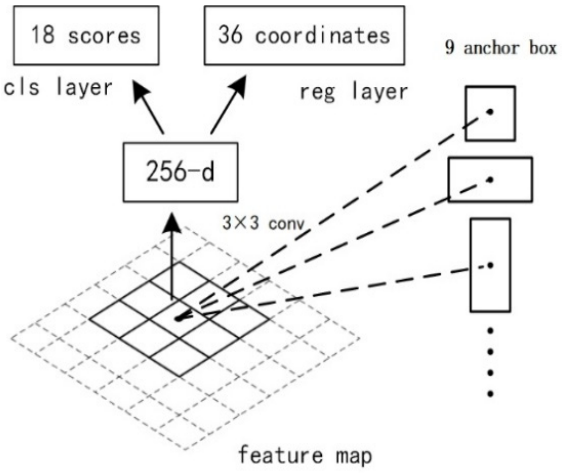
Figure 7. RPN structure